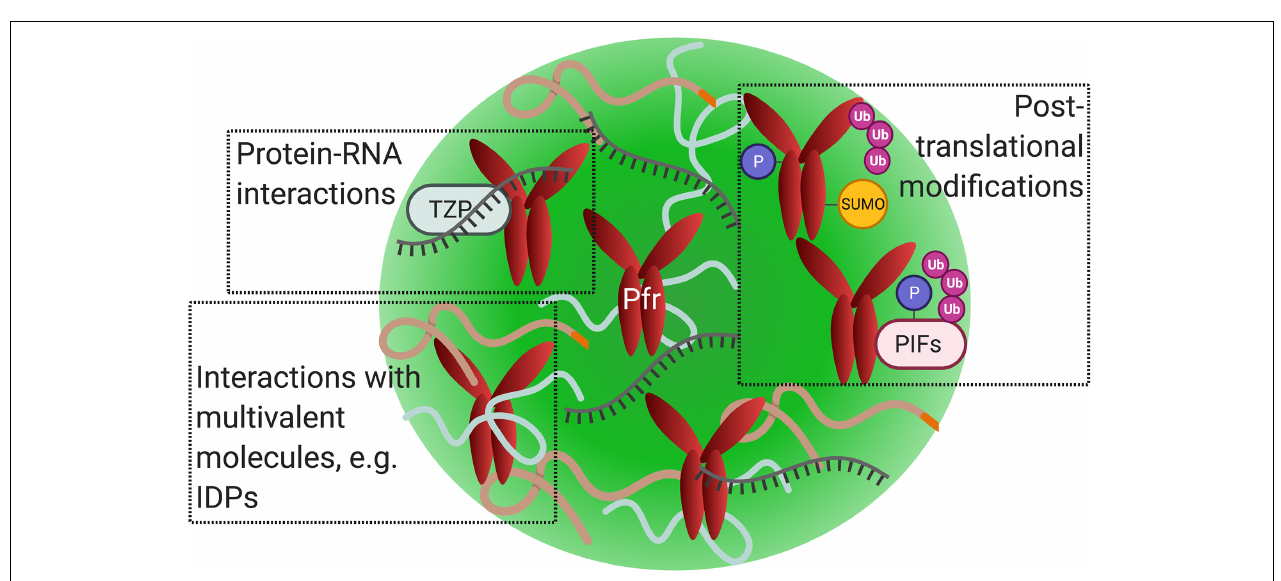
FIGURE 4 | Phytochrome photobodies may share features associated with other nuclear biomolecular condensates. Illustration of active phytochrome (Pfr) within a single photobody (green sphere). Factors that promote nuclear condensate formation via liquid-liquid phase separation, including protein – protein interactions, protein – nucleic acid interactions, and posttranslational modifications, may also function in photobodies. (Top left) Phytochrome photobodies may contain nucleic acids, as demonstrated by the co-localization of RNA with TZP-phyB nuclear bodies. (Top right) Phytochromes undergo posttranslational modifications such as SUMOylation, phosphorylation, and polyubiquination. Phytochromes target PIFs for phosphorylation and polyubiquitination. (Bottom left) Multivalent molecules, such as intrinsically disordered proteins (curved lines), may promote photobody